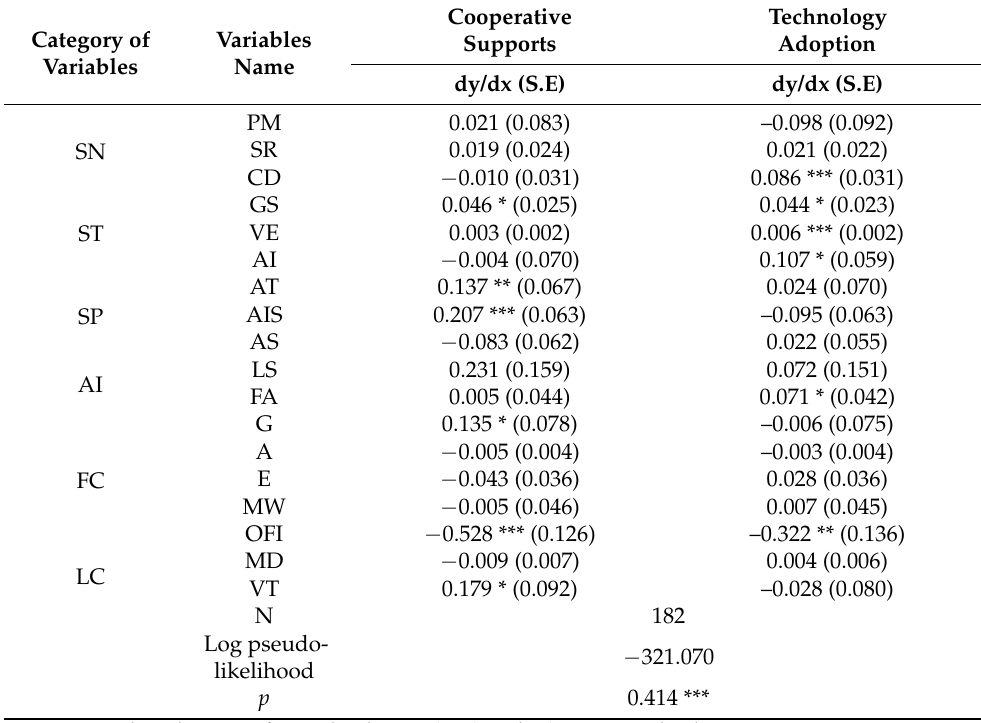
Table 7. The marginal influence of DSM on low-income farmer’s first-step regression findings.